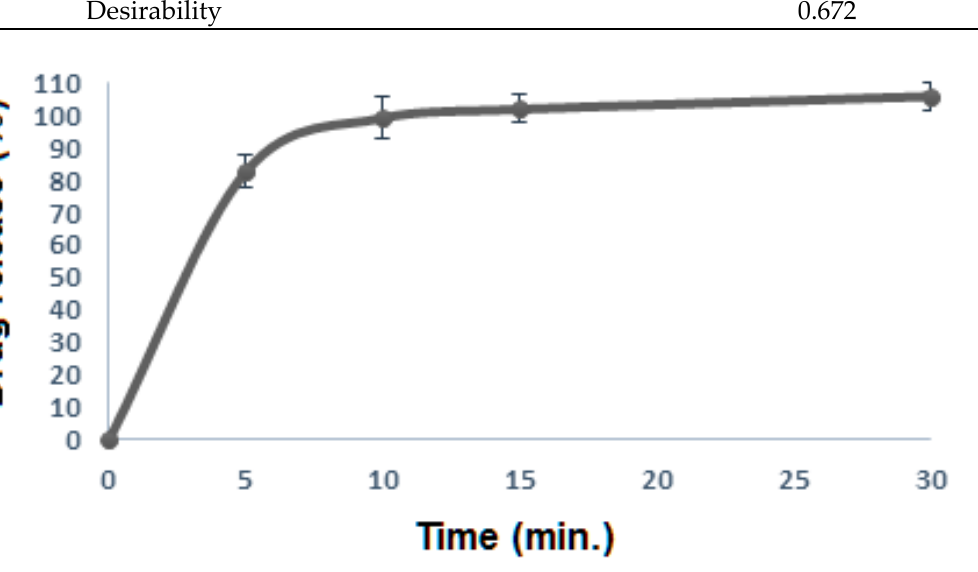
Figure 16. FLB release from the optimized film formula.